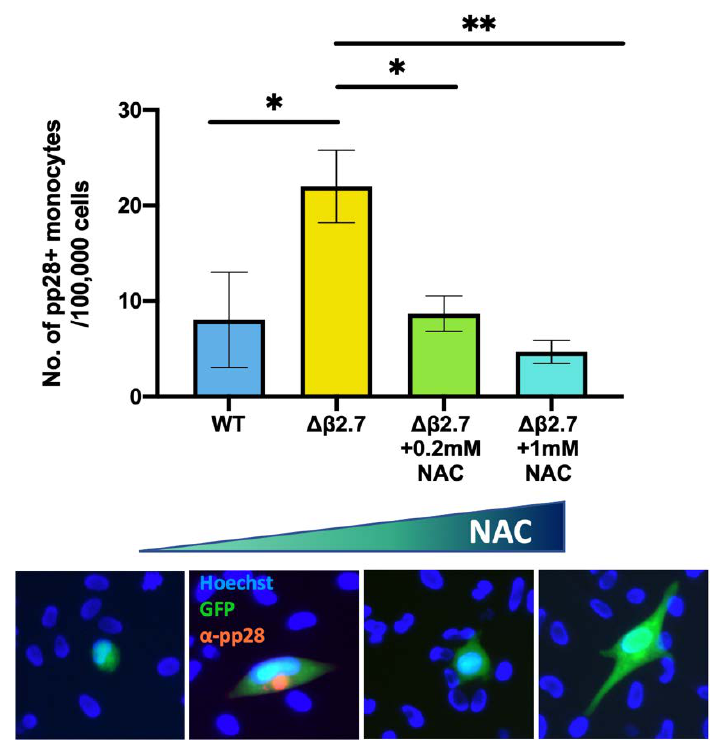
Figure 8. The antioxidant, NAC, reduces the number of Δβ2.7 infected monocytes that fail to establish or maintain latency. CD14+ monocytes were pretreated with the indicated concentrations of the antioxidant, NAC, for 2 h, and were then infected with Δβ2.7 TB40E SV40 - GFP (Δβ2.7) virus at an MOI of 5. Every 2 days, cells were provided with fresh media containing the appropriate amount of NAC. At 7 d.p.i, cells were fixed and stained for the late lytic protein, pp28 and pp28-positive monocytes were counted for each condition performed in triplicate. Error bars show standard deviation. Significance was calculated using a one-way ANOVA with Dunnett’s post hoc testing. * = p < 0.05, ** = p < 0.01. Merged colour channel images for each condition were produced on ImageJ (20x). Exposure of green channel was reduced in some images for clarity.